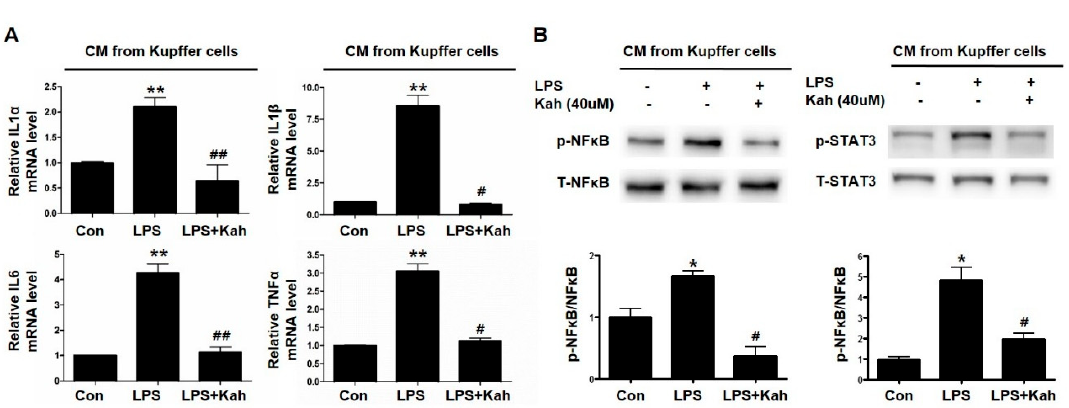
Figure 6. Kahweol inhibited primary HC inflammation induced by conditioned media in primary KC treated with LPS. ( A ) Representative real time RT-PCR analysis of the expression levels of IL1 α , IL1 β , IL6, and TNF α in primary HC treated with conditioned media (CM) from LPS and kahweol treated primary KC. ** p < 0.01 compared with control (con), # p < 0.05, ## p < 0.01 compared with LPS. ( B ) Representative western blot of phospho (p)-NF κ B and phospho (p)-STAT3 expression in primary HC treated with CM form LPS and kahweol treated primary KC. Data represented in the bar graph are the mean ± SEM of three independent measurements. * p < 0.05 compared with control (Con), # p < 0.05 compared with LPS. T- NF κ B, total NF κ B, T-STAT3, total STAT3.